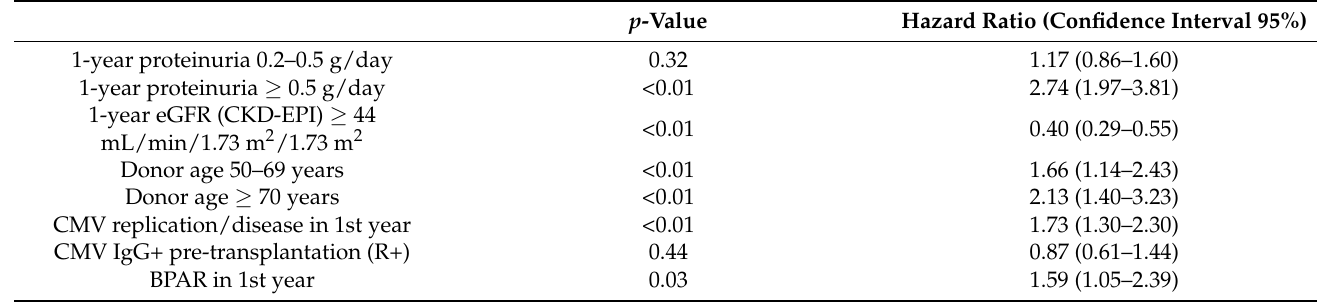
Table 4. Multivariate analysis for determinants of graft outcome